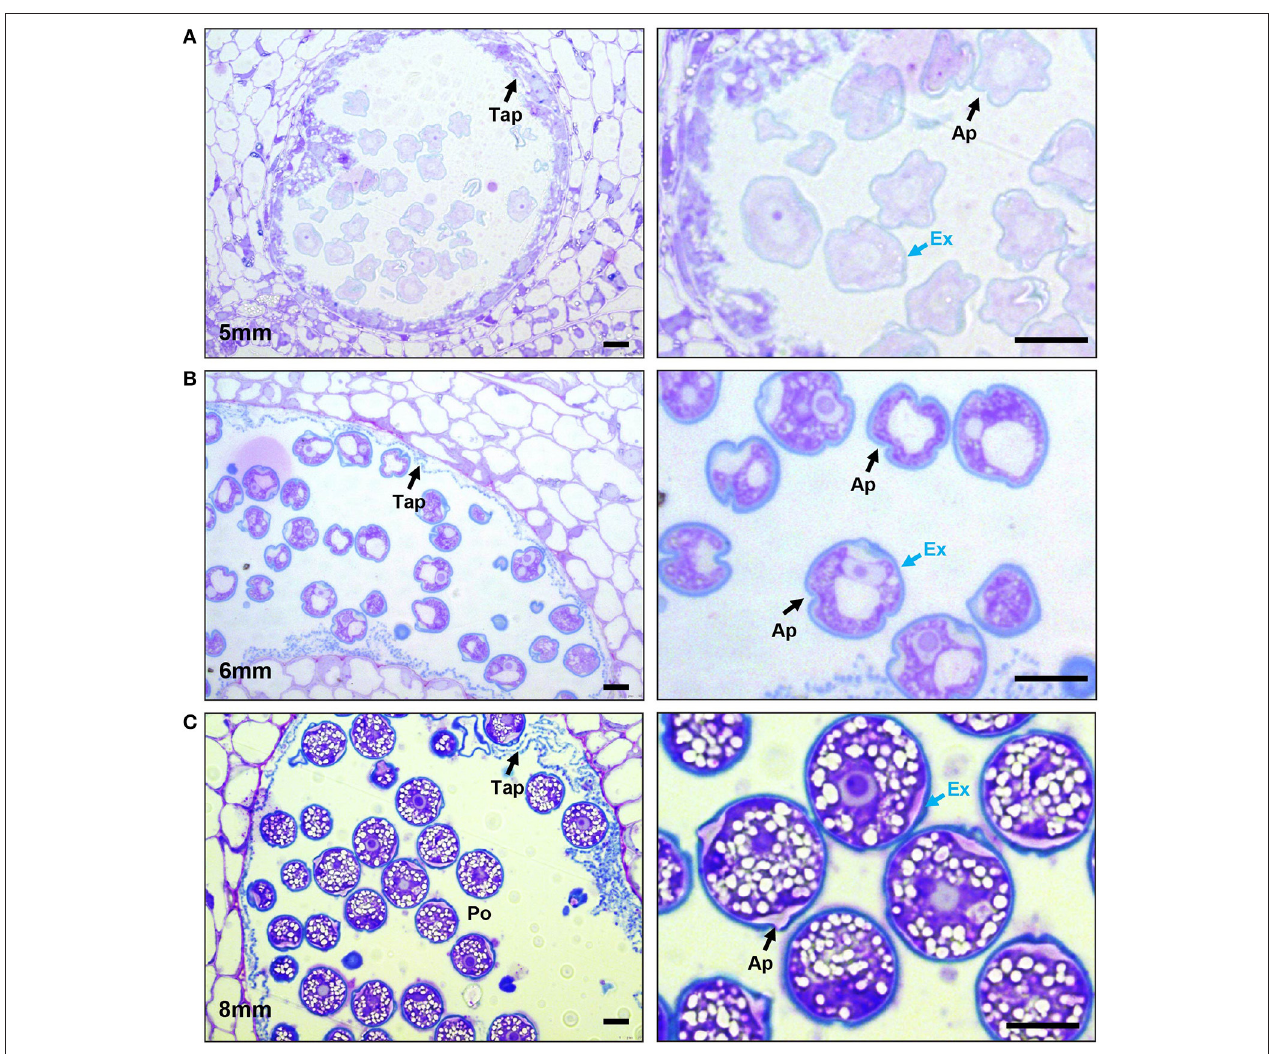
FIGURE 3 | Progression of exine deposition. Micrographs of LR White embedded 500-nm thick anther cross sections, stained with toluidine blue. (A) The uninucleate microspore stage at 5-mm bud length. Cross section of anther locule (Left), The arrow marks the tapetum. Close-up of microspores (right), black arrow marks aperture; the blue arrow marks the exine. (B) The bicellular pollen stage at 6-mm bud length. Cross section of anther locule (left); the arrow marks the tapetum. Close-up of microspores (right), black arrow marks aperture; the blue arrow marks the exine. (C) The mature pollen stage at 8-mm bud length. Cross section of anther locule (left); the arrow marks the tapetum. Close-up of microspores (right); the black arrow marks aperture; the blue arrow marks the exine. Ex, exine; Tap, tapetum; Po, pollen; Ap, aperture. All scale bars are 10 µ m.